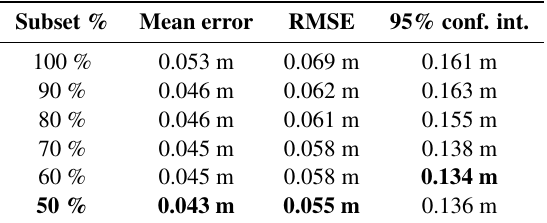
Table 3. Localisation results (mean error, Root Mean Square Error and 95% confidence interval) for varying subset